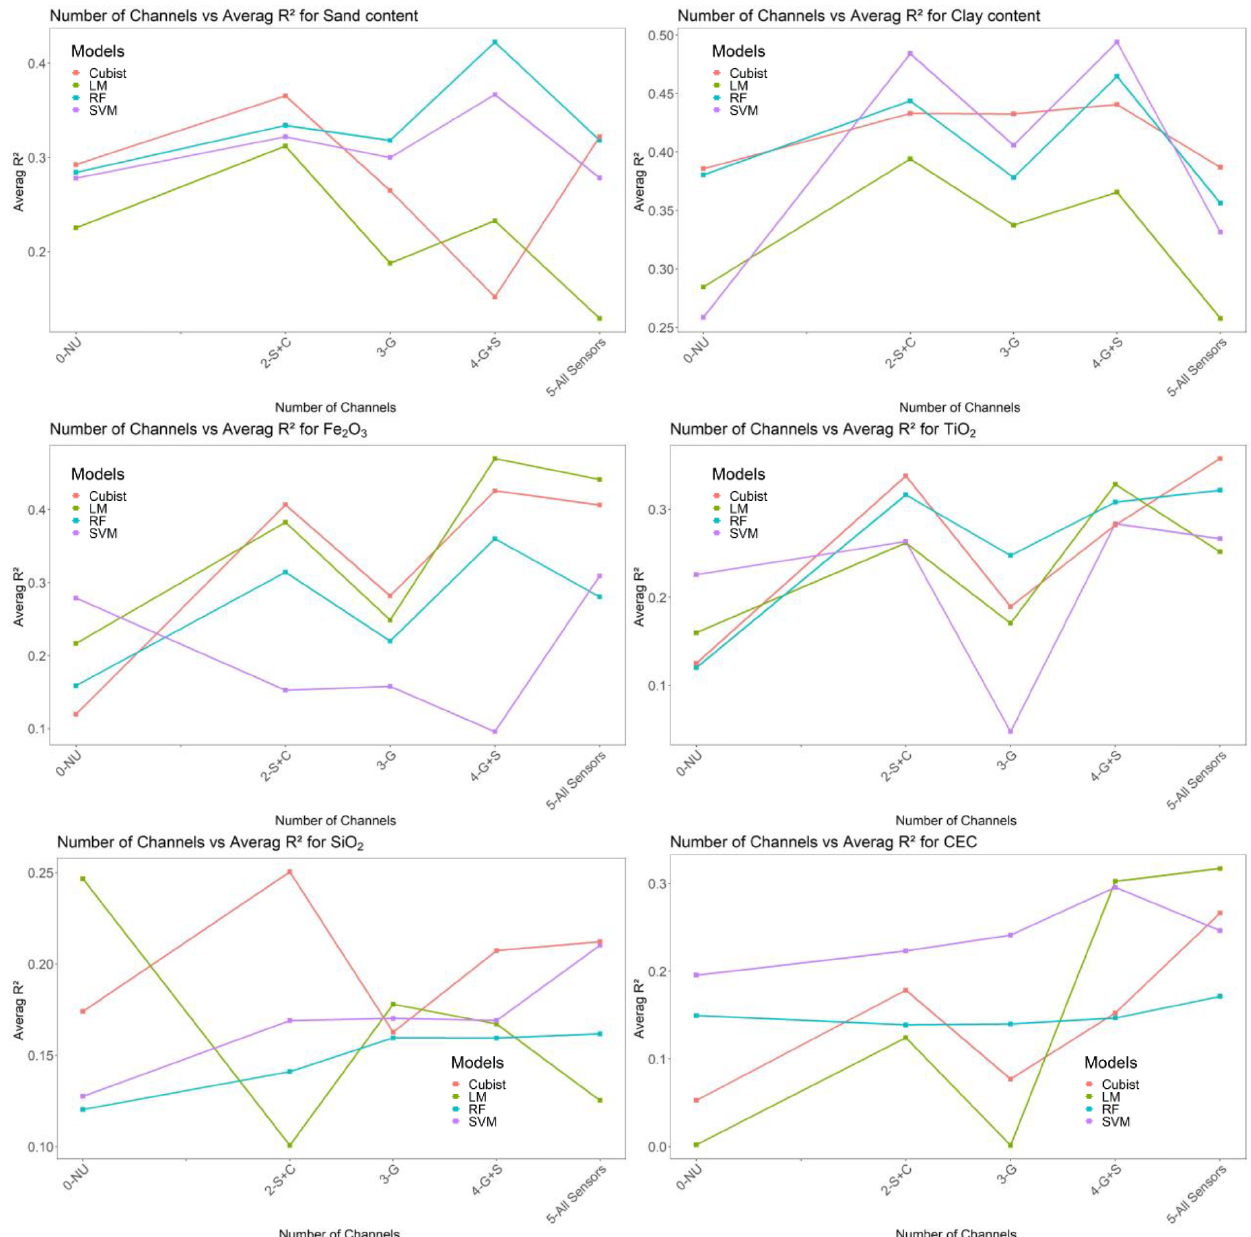
Figure 9. Learning curves calculated on the metric by which the parameters of the model were optimized and on the metric by which the model was evaluated and selected. The most common form of learning curves in the general field of machine learning shows predictive accuracy on the test examples as a function of the number of training examples (Perlich,